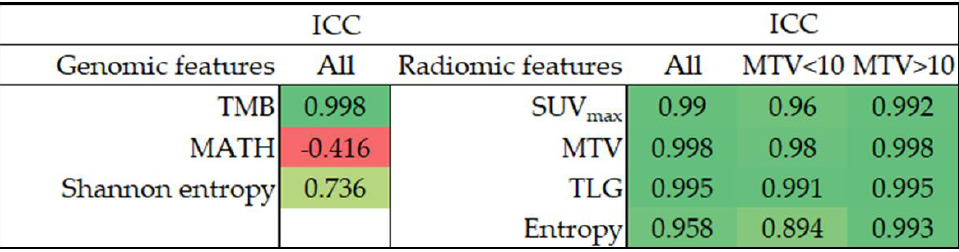
Figure 1. The ICC of radiogenomic features. ICC, intraclass correlation coefficient; TMB, tumor mutation burden; MATH, mutant-allele tumor heterogeneity; SUV, standardized uptake value; MTV, metabolic tumor volume; TLG, total lesion glycolysis.